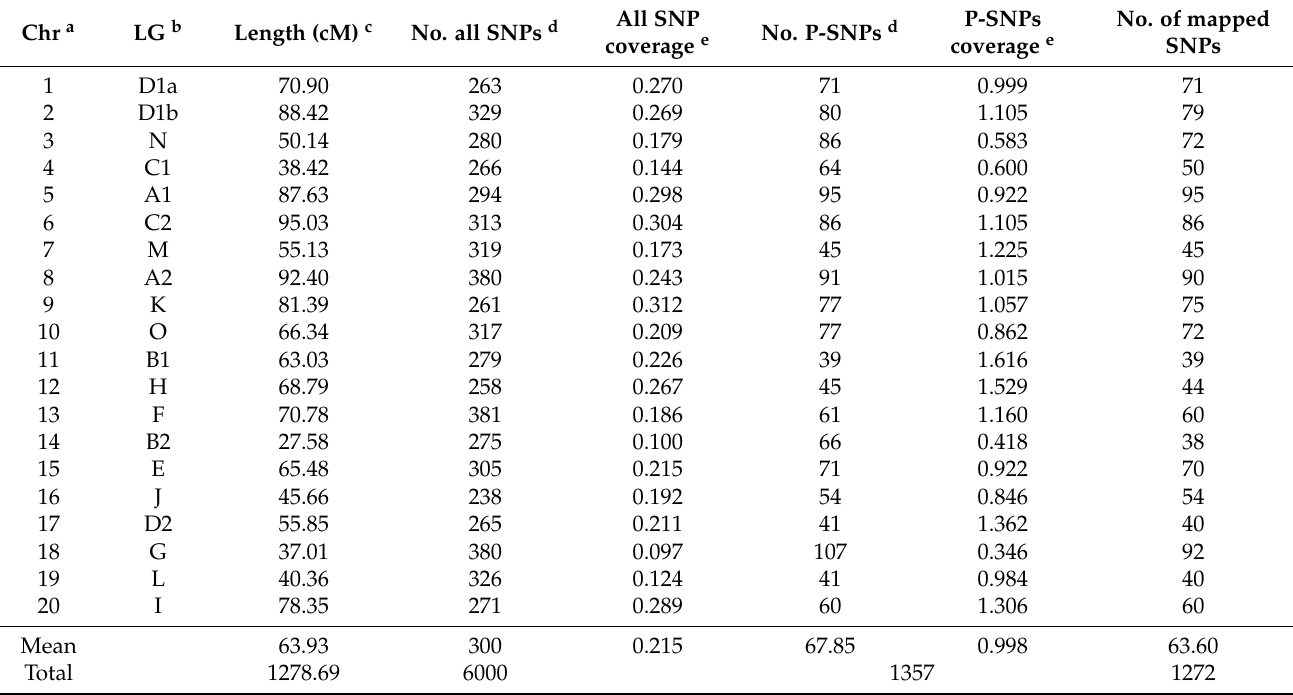
marker was able to select 86% of the low KTI PIs from the core collection (Table 2). Figure 4 shows the results of the cluster analysis of Gm08_44814503 SNP marker where 31 lines showed the normal KTI genotype, three lines showed the heterozygous genotype and 59 lines showed the low KTI genotype, the last two samples in the graph belong to Glenn (normal KTI) and PI 547,656 (low KTI). Table 5. Summary of single nucleotide polymorphism (SNP) marker mapping in F3-derived F5 mapping population from Glenn x PI 547656.